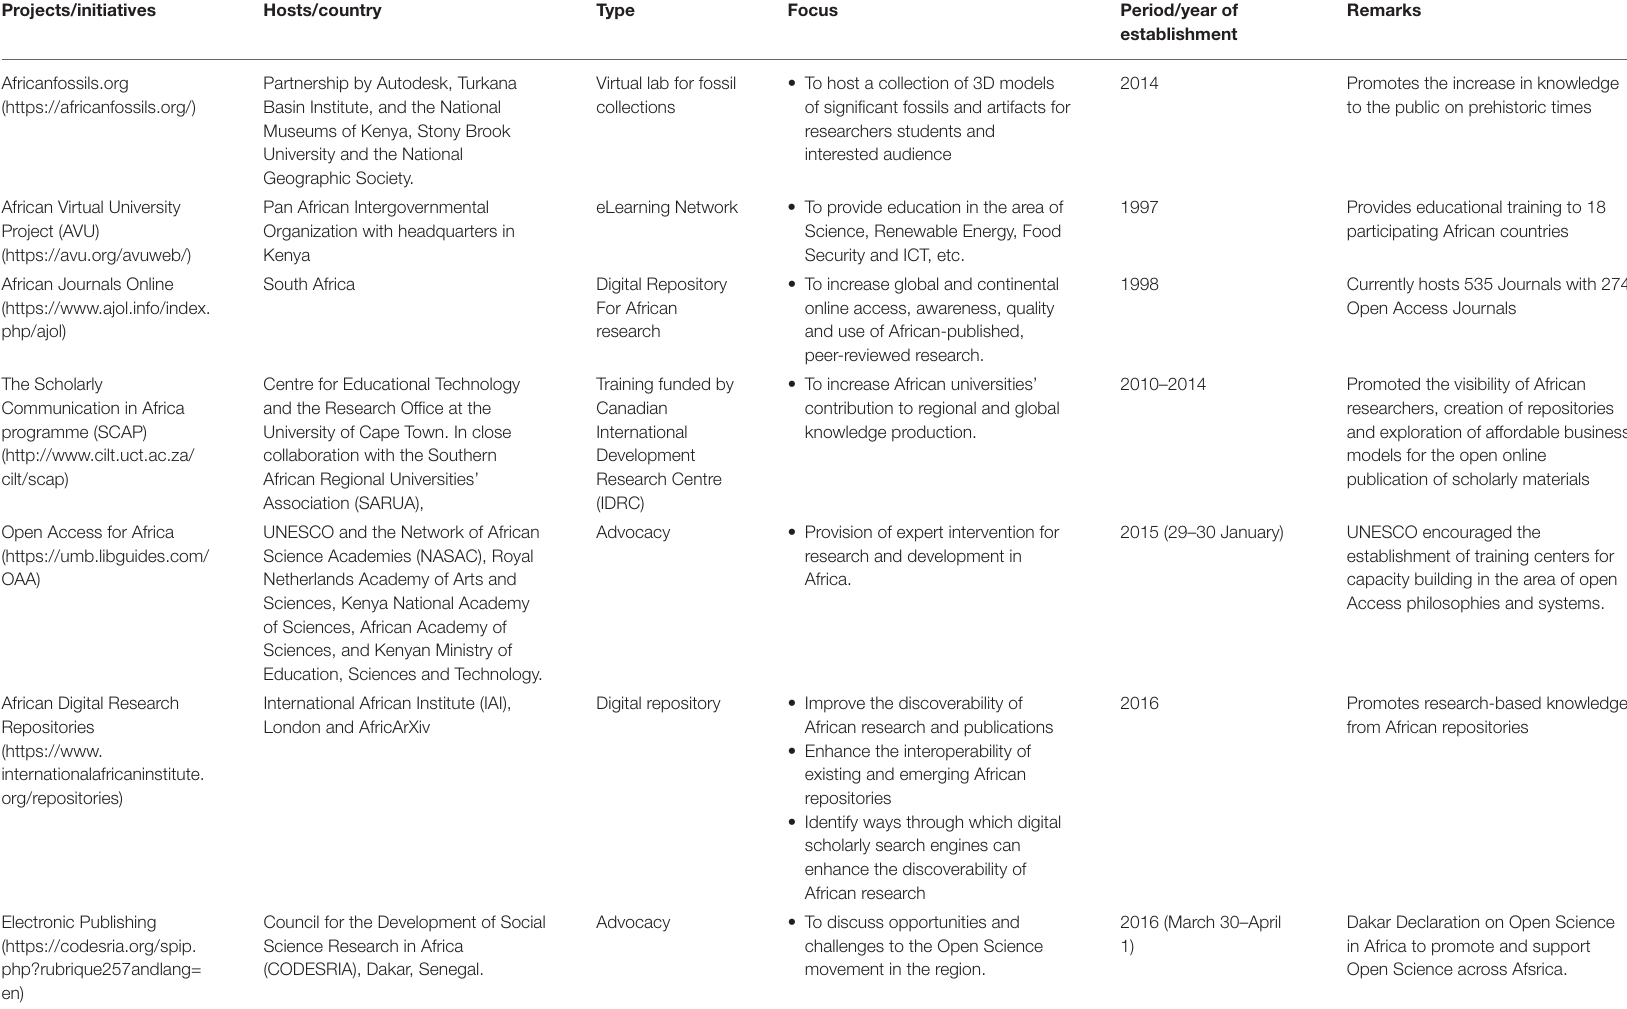
TABLE 1 | Some open science initiatives/platforms in